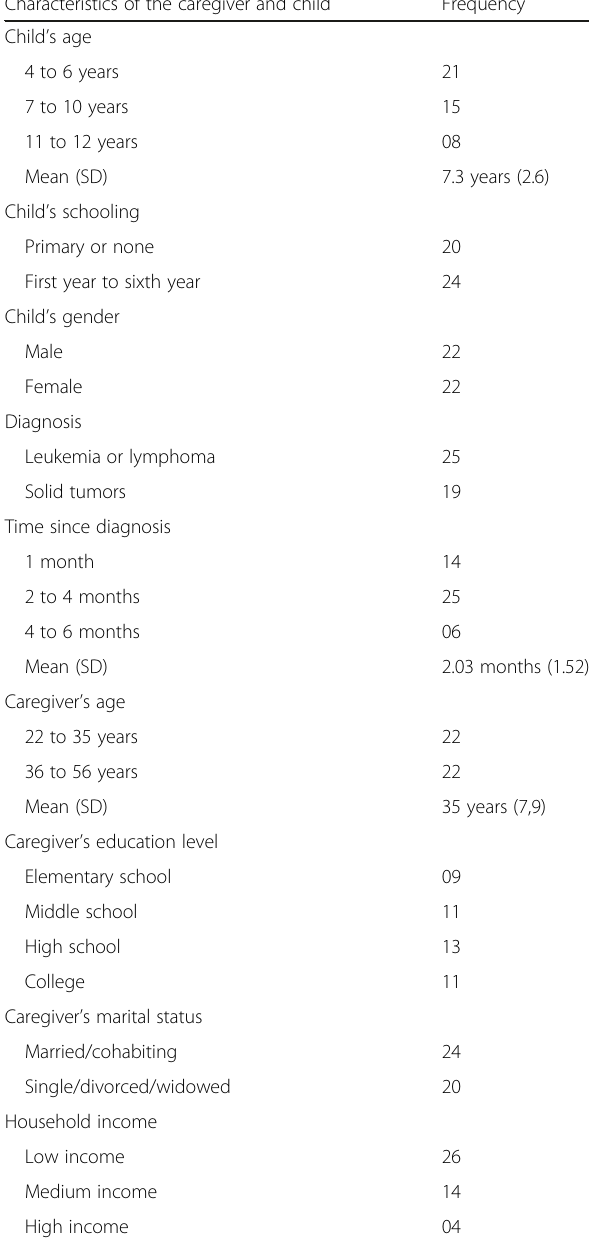
Table 1 Characteristics of the Caregiver and Child Characteristics of the caregiver and